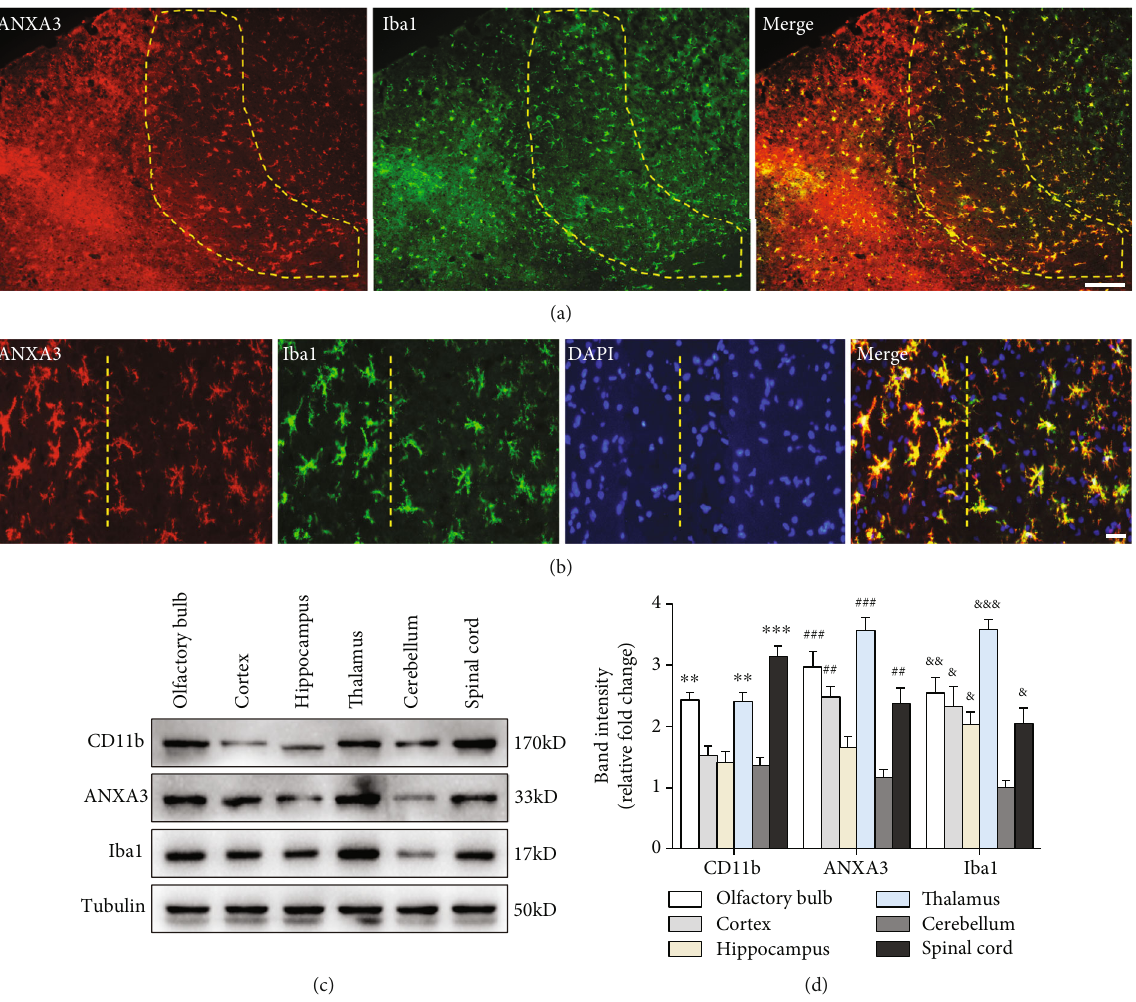
Figure 5: Morphologies of microglia labeled by ANXA3 and ANXA3 protein expression levels in di ff erent regions. (a) Low-magni fi cation micrographs showing microglial cells in the ischemic penumbra 3 days after reperfusion. The yellow-dotted ring indicates the ischemic penumbra area between the infarct area and the normal area of the brain tissue. Scale bars = 200 μ m . (b) Representative immuno fl uorescence images showing the morphology of activated microglia in the ischemic penumbra (on the left) and resting microglia in the healthy area (on the right) labeled by ANXA3 and Iba1 at high magni fi cation. Scale bars = 50 μ m . n = 5 per group. (c, d) The expression levels of ANXA3, CD11b, and Iba1 proteins in the olfactory bulb, cortex, hippocampus, thalamus, cerebellum, and spinal cord of adult rats (3 months) were determined by Western blotting analysis. The panel shows protein bands corresponding to ANXA3, CD11b, Iba1, and tubulin. The histogram shows the results of the densitometric analysis. The data are expressed as the means ± SD and were analyzed by one-way ANOVA with Tukey ’ s post hoc test. ∗∗ p < 0 : 01 and ∗∗∗ p < 0 : 001 compared with the cerebellum group. ## p < 0 : 01 and ### p < 0 : 001 compared with the cerebellum group. & p < 0 : 05 , && p < 0 : 01 , and &&& p < 0 : 001 compared with the cerebellum group. n = 6 per